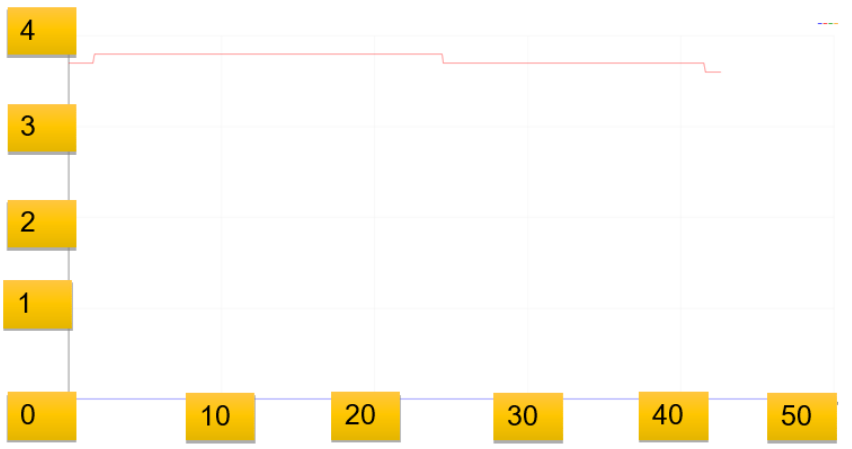
Figure 11. Humidity sensor at Room Temperature.